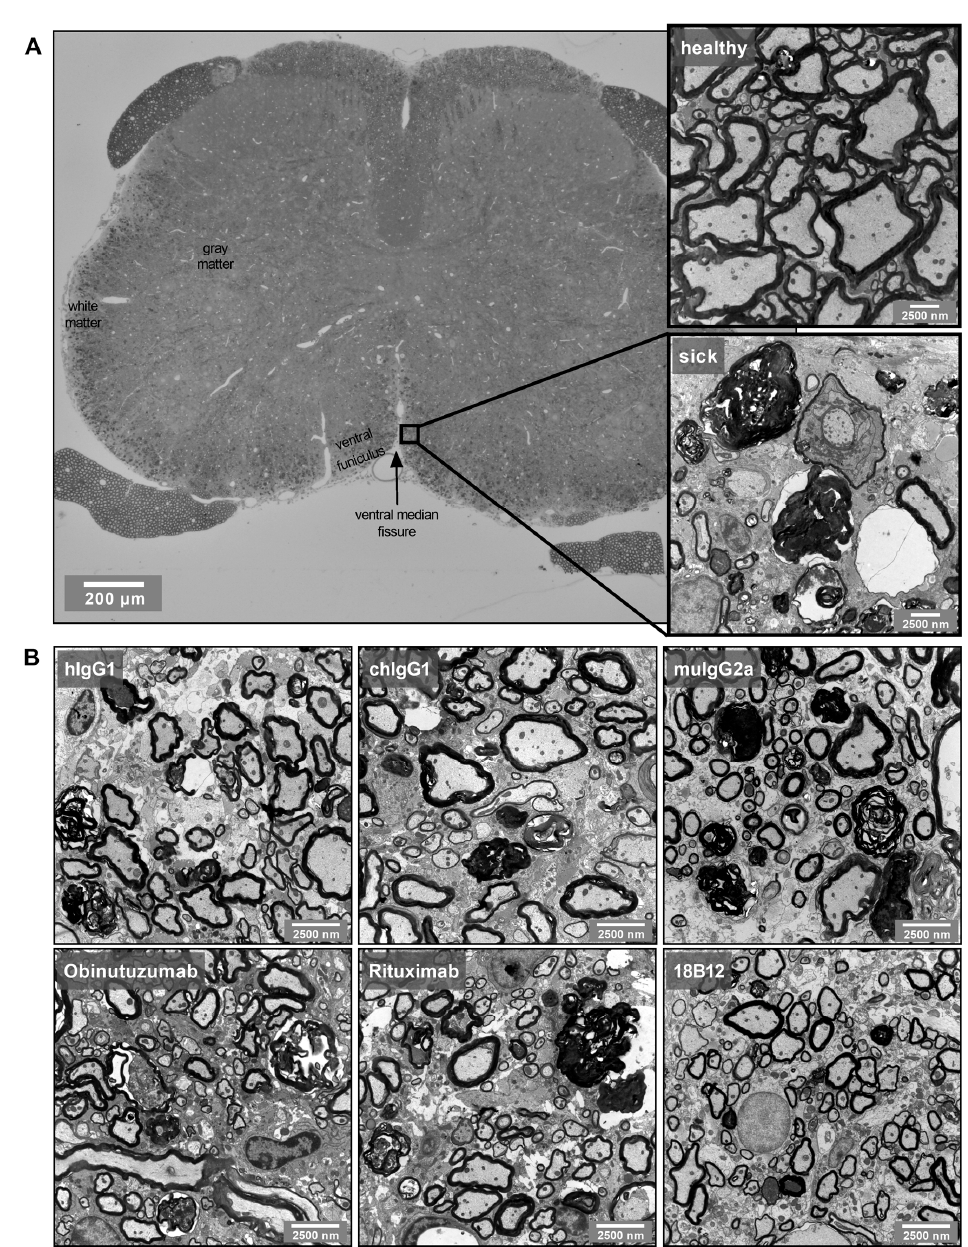
Figure 7. Representative spinal cord EM images: ( A ) EM images were taken from the ventral funiculus of transverse spinal cord sections. The magnifications show the difference between healthy and EAE (sick) tissue. ( B ) Representative EM images from the different isotype control- and anti-CD20 mAb-treated groups.